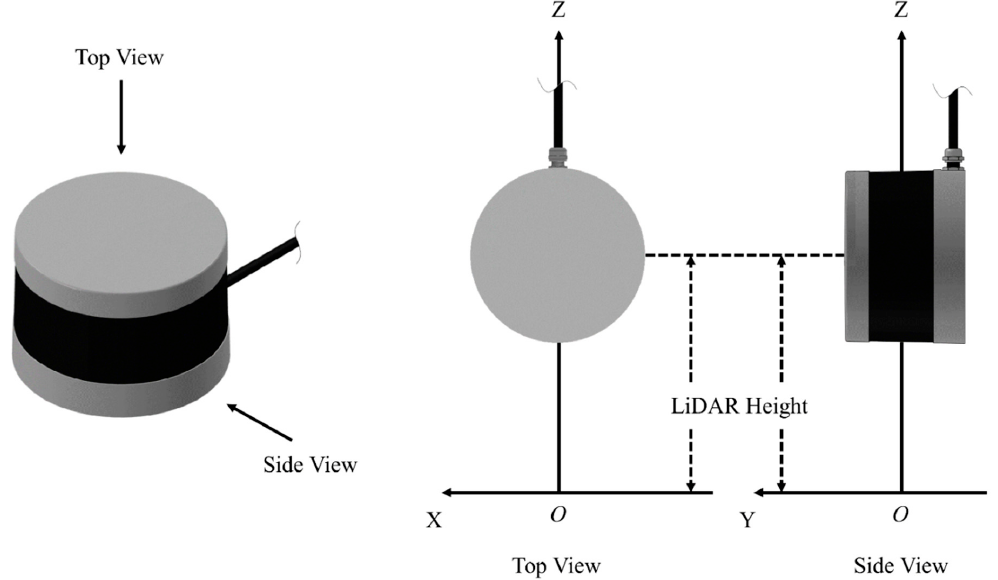
Figure 4. The Cartesian coordinate system for LiDAR point cloud at each measurement.